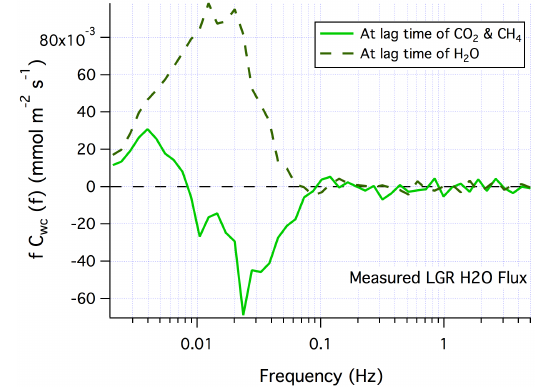
Figure 9. Mean cospectra of LGR H 2 O flux for the air–water wind sector, computed at the optimal lag time of CO 2 / CH 4 (3s) and the optimal lag time of H 2 O ( ∼ 20s). The much longer lag time of H 2 O is due to severe high-frequency attenuation of H 2 O in the inlet tube (e.g. no flux signal above ∼ 0.1Hz). Even at the optimal lag time, measured H 2 O flux is only about 10% of the predicted latent heat flux (mean of 120Wm − 2 )